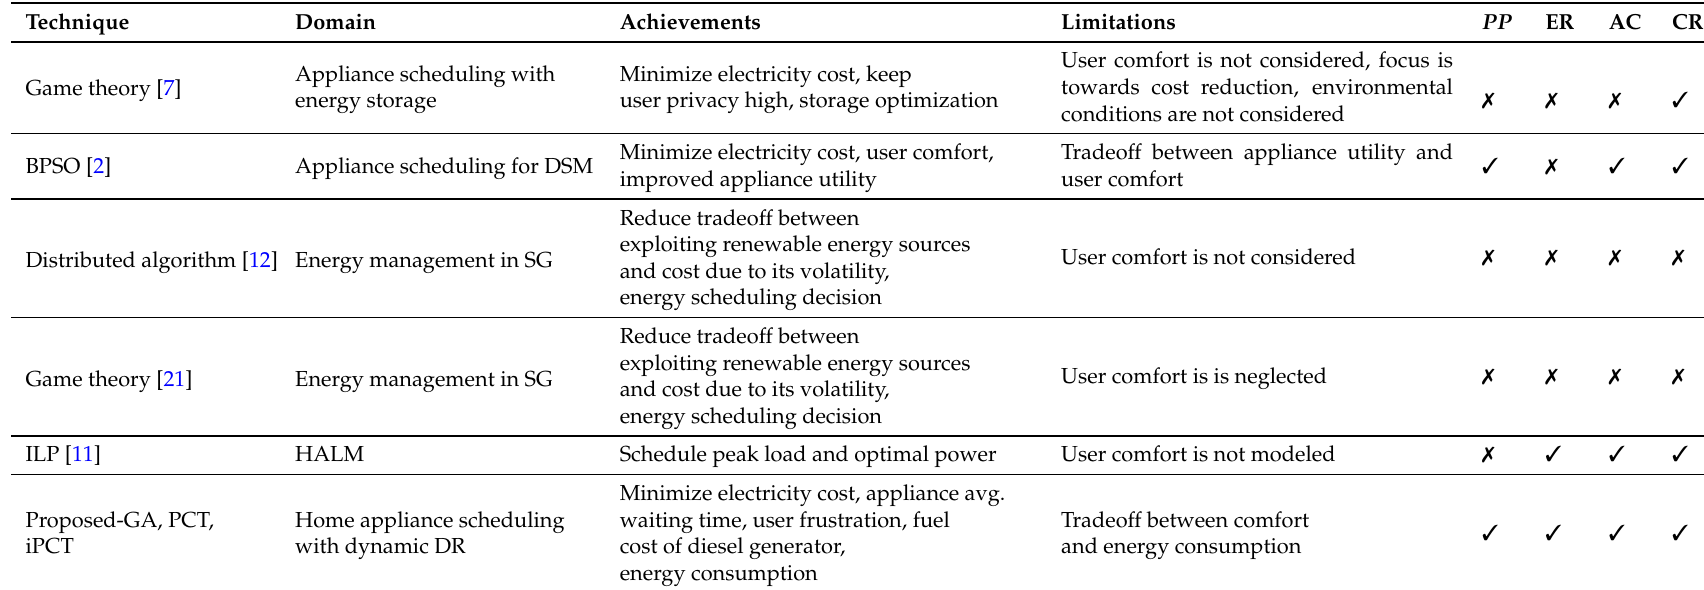
Table 8. Performance comparison of the proposed scheme with existing schemes, PP : person presence; AC: appliance categorization; PS: pricing scheme; ER : energy reduction; CR: cost reduction; DSM: demand side management; SG: smart grid; ILP: integer linear programming; HALM: home area load management;